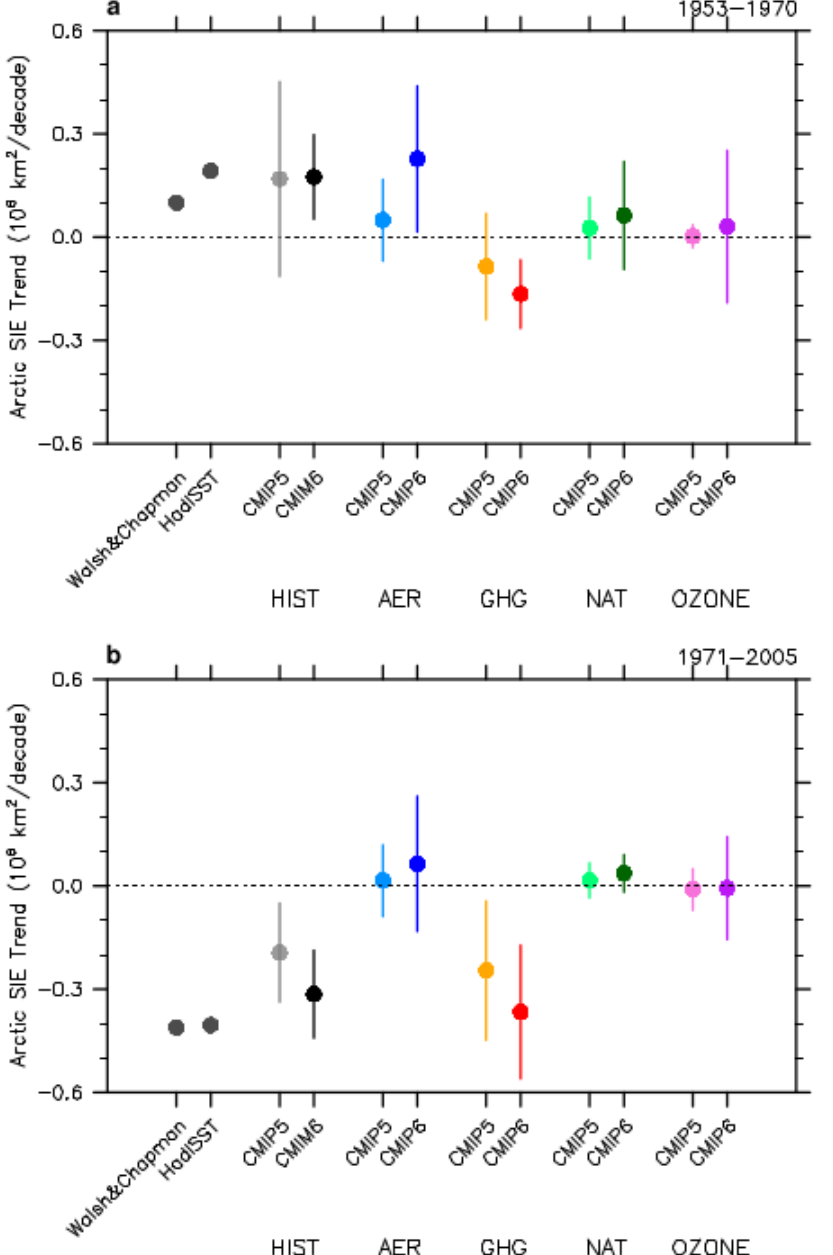
Figure 3. ( a ) Linear trends of annual mean Arctic sea ice extents from Walsh and Chapman and HadISST data (gray dots) and CMIP5 and CMIP6 historical (light gray and black), AER (light blue and blue), GHG (orange and red), NAT (light green and green) and OZONE (light purple and purple) simulations over 1953–1970. For the CMIP5/6 model’s results, dots indicate MMMs, and bars indicate inter-model spreads. ( b ) Same as ( a ) but for trends over